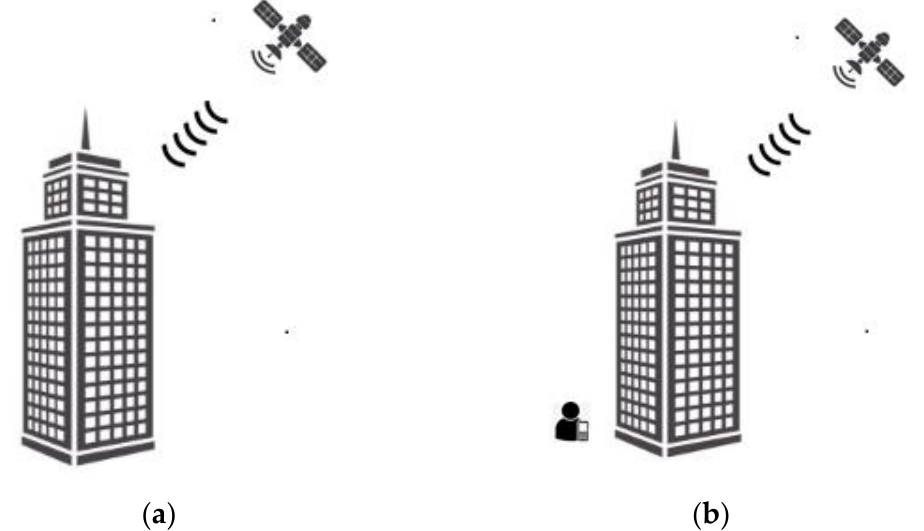
Figure 2. ( a ) GPS signal is blocked inside the building and ( b ) GPS signal is blocked by a tall building.